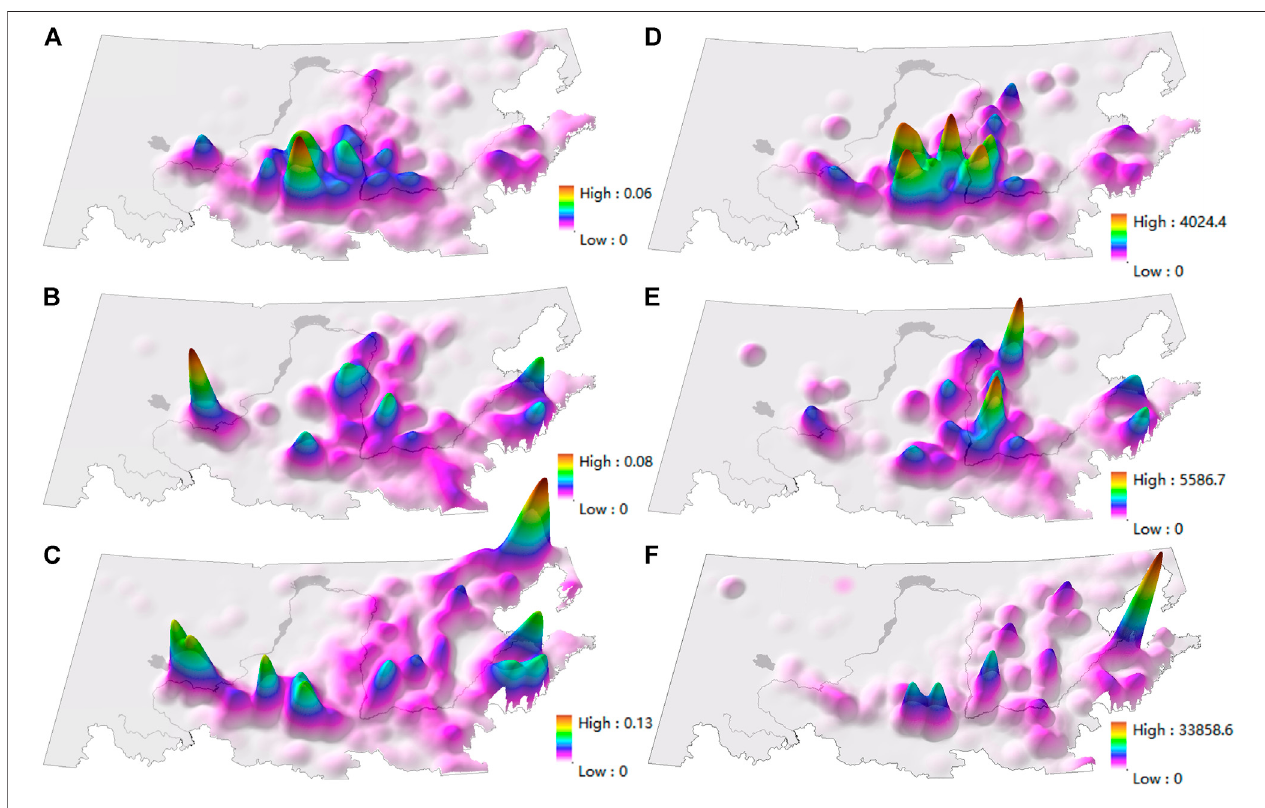
FIGURE4| Resultsofkerneldensity(withandwithoutspecifyingweight). (A) SitenumberdensityofYangshaosites. (B) SitenumberdensityofLongshansites. (C) Site number density of the Bronze Age site. (D) Area density of Yangshao sites. (E) Area density of Longshan sites. (F) Area density of Bronze Age sites.